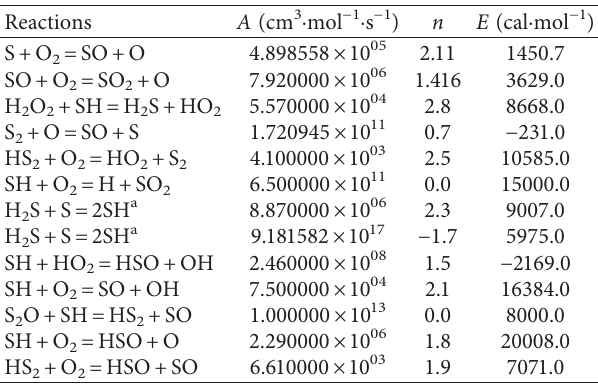
Figure 2: Schematic mechanism for fuel-lean H Table 2: Relevant reactions of the kinetic scheme.